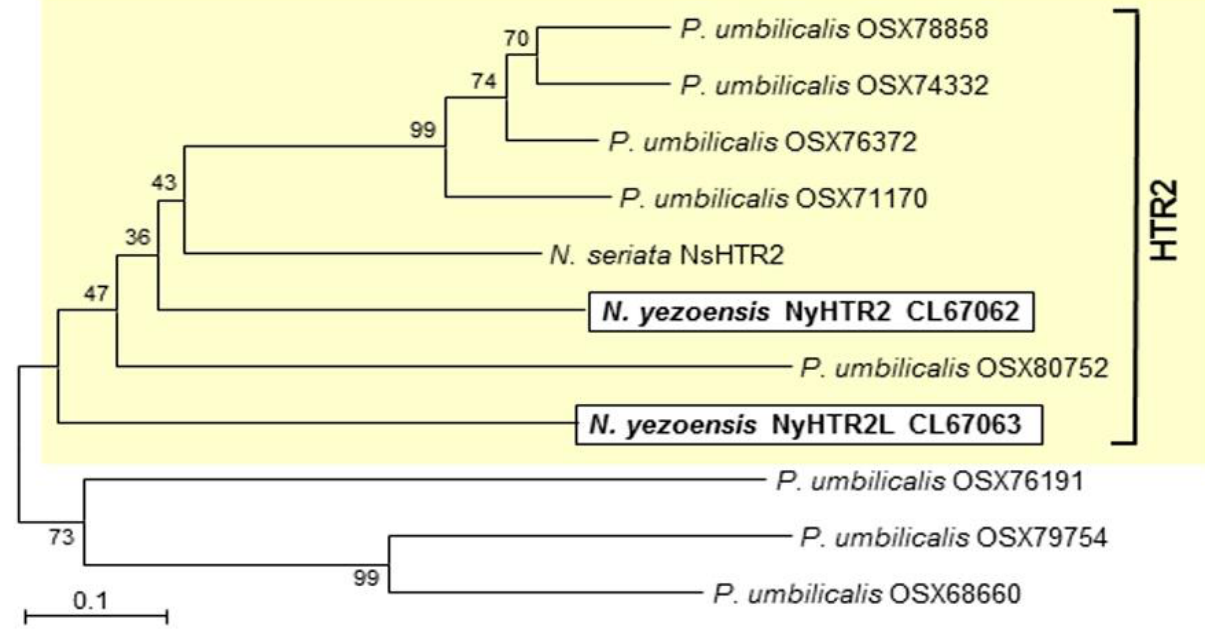
Figure 1. HTR2 homologs are conserved in the Bangiales. DDBJ/EMBL/GenBank accession numbers of homologs are indicated after species names. HTR2 homologs from Neopyropia yezoensis are highlighted and boxed. The bootstrap values with 1000 replicates are indicated at the nodes of the tree. Bar, 0.1 substitutions per site.